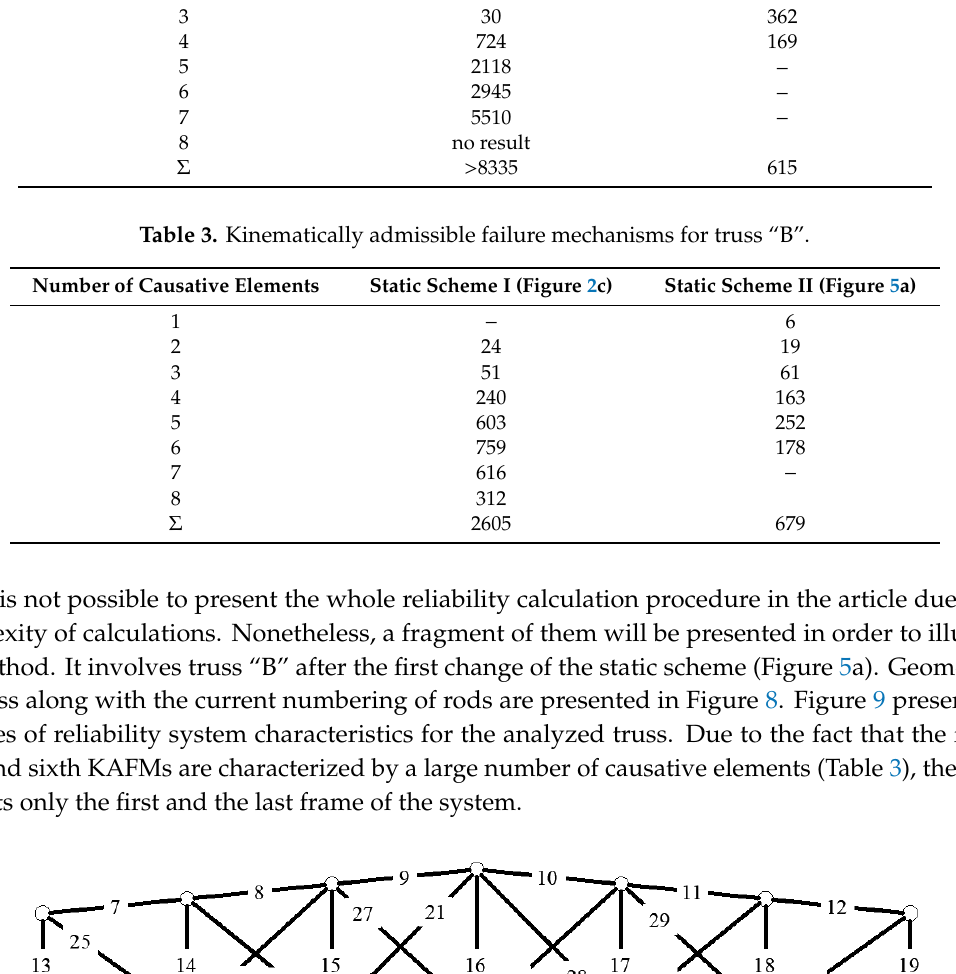
Table 2. Kinematically admissible failure mechanisms for truss “A”.